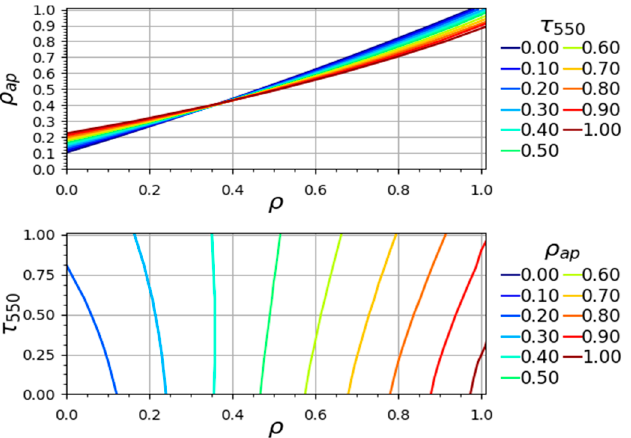
Figure 5. LUTs calculated from the custom aerosol model, demonstrate the ρ - τ relationship for custom aerosol model calculated for Himawari-8 band 1 image on 6 January 2020. The top panels show the relation between ρ and ρ ap , while bottom panels indicate the relation between ρ and τ 550